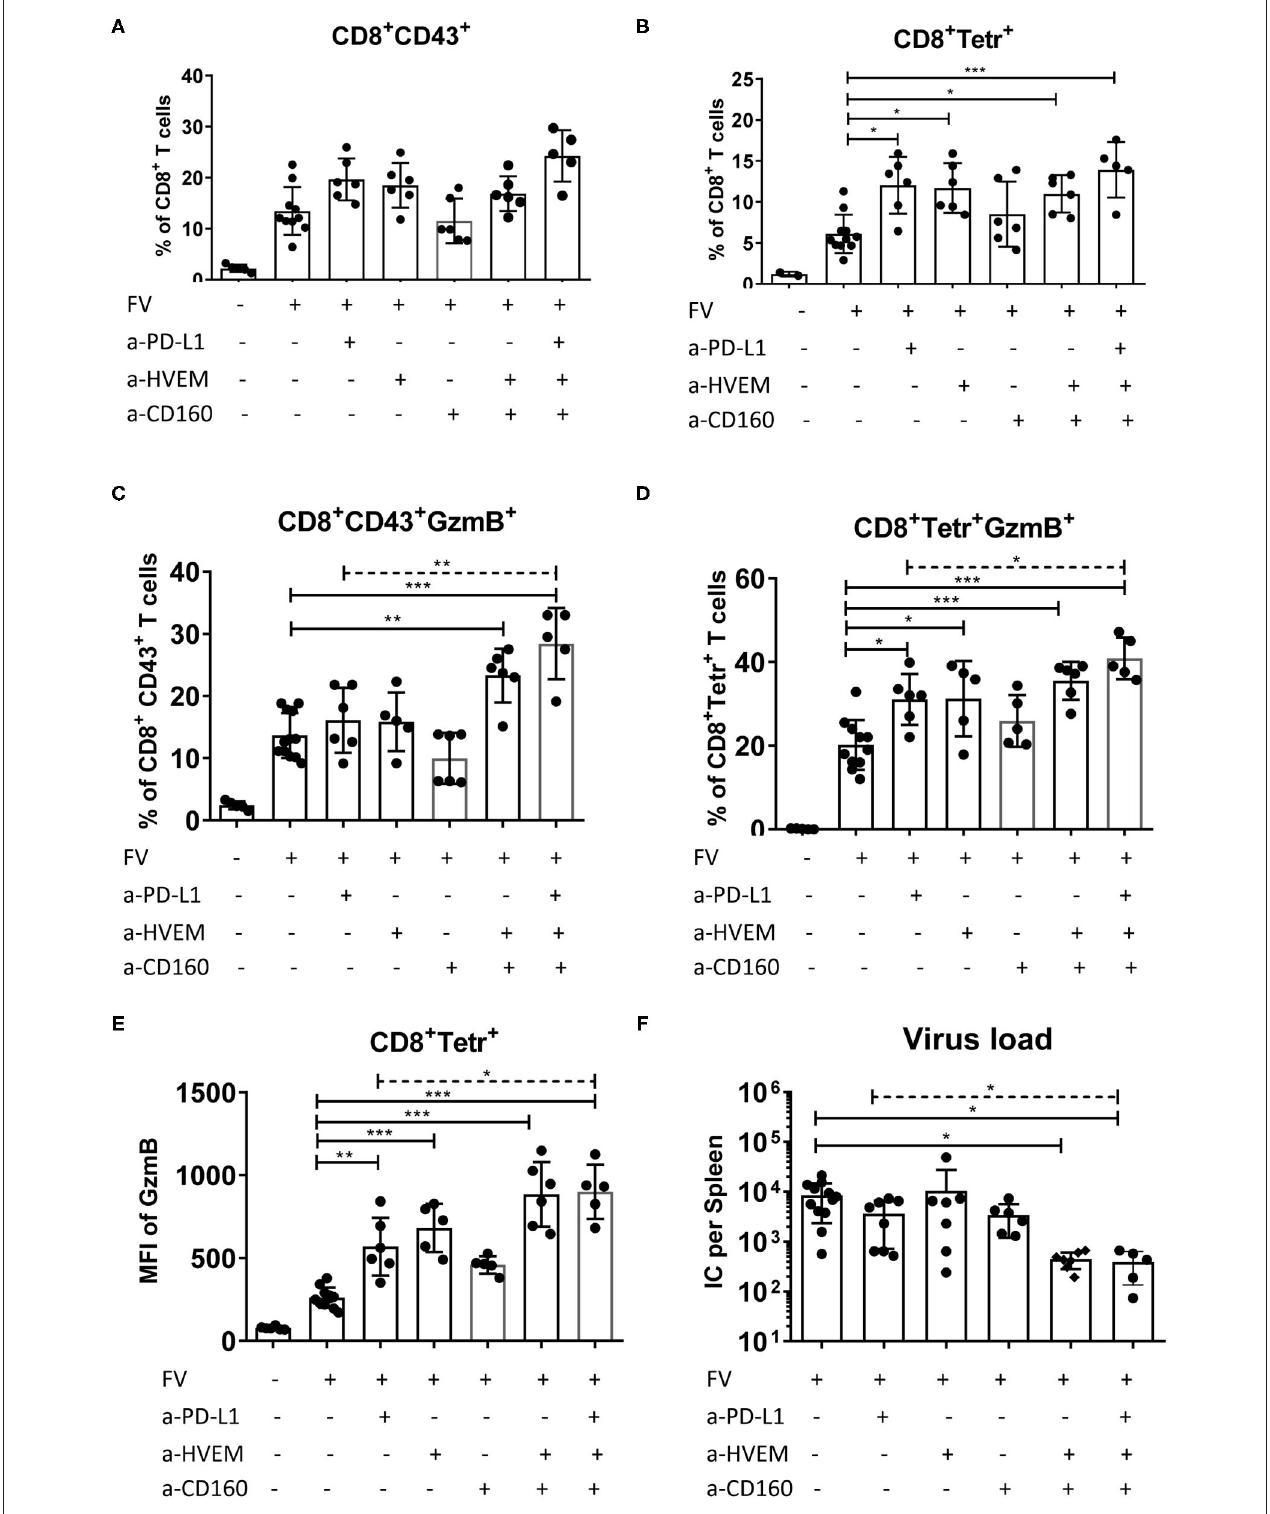
FIGURE 7 | Influence of blocking PD-L1 interaction with PD-1 and HVEM interaction with CD160 and BTLA on effector CD8 + T cells. C57BL/6 mice were infected with FV and treated with anti-PD-L1 antibody blocking the interaction with PD-1 on day 6, 8 and 10 after infection, and/or with anti-HVEM antibody blocking